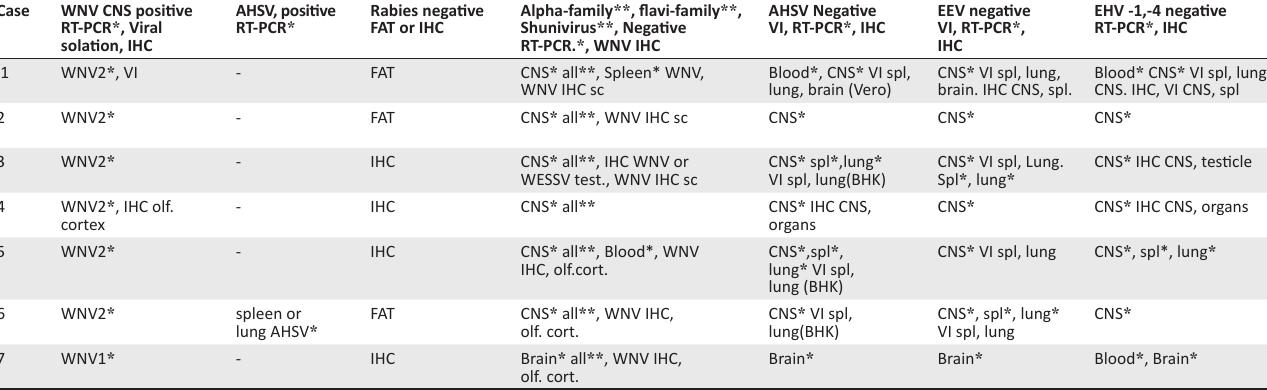
TABLE 2: Viruses that tested positive and negative in central nervous system and other tissues by various diagnostic tests in equine Cases 1–7. Case WNV CNS positive RT-PCR * , Viral solation,